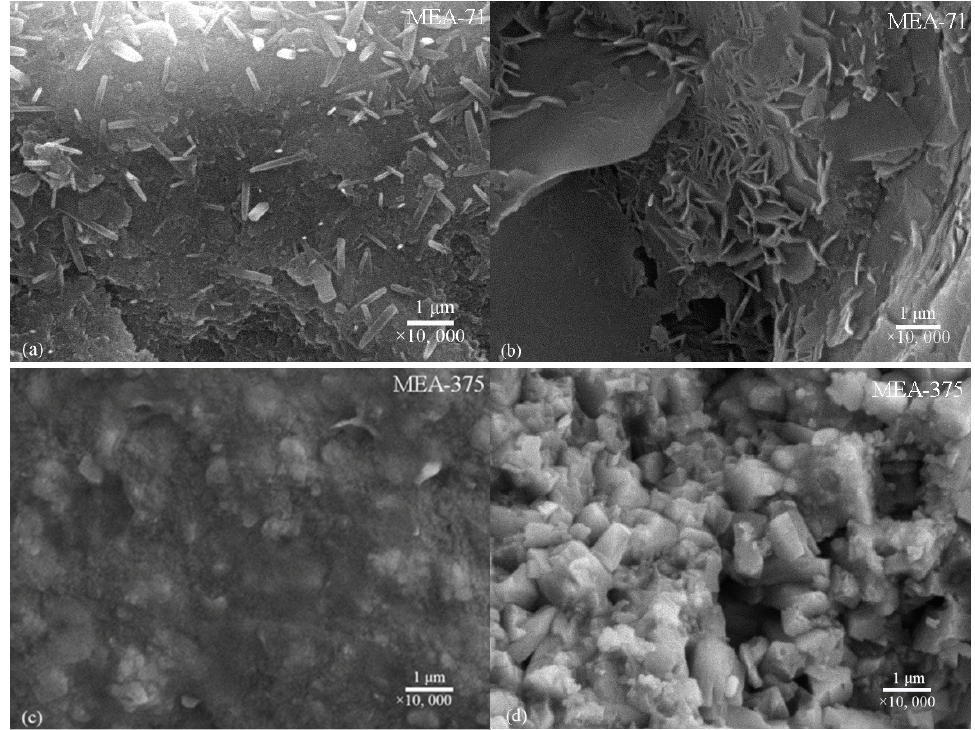
Figure 7. Scanning electron microscopy (SEM) images of the fracture surface of compacted MEAs cured in water at 40 °C when the expansion stresses stabilized: ( a , b ) compacted MEA-71, and ( c , d ) compacted MEA-375.